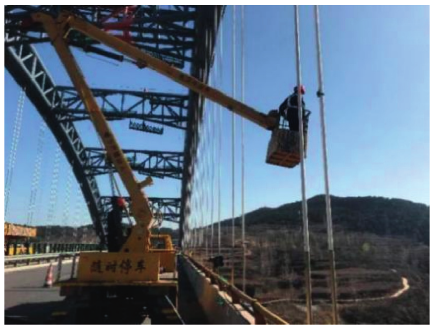
Figure 18: Testing of the suspender cable force.